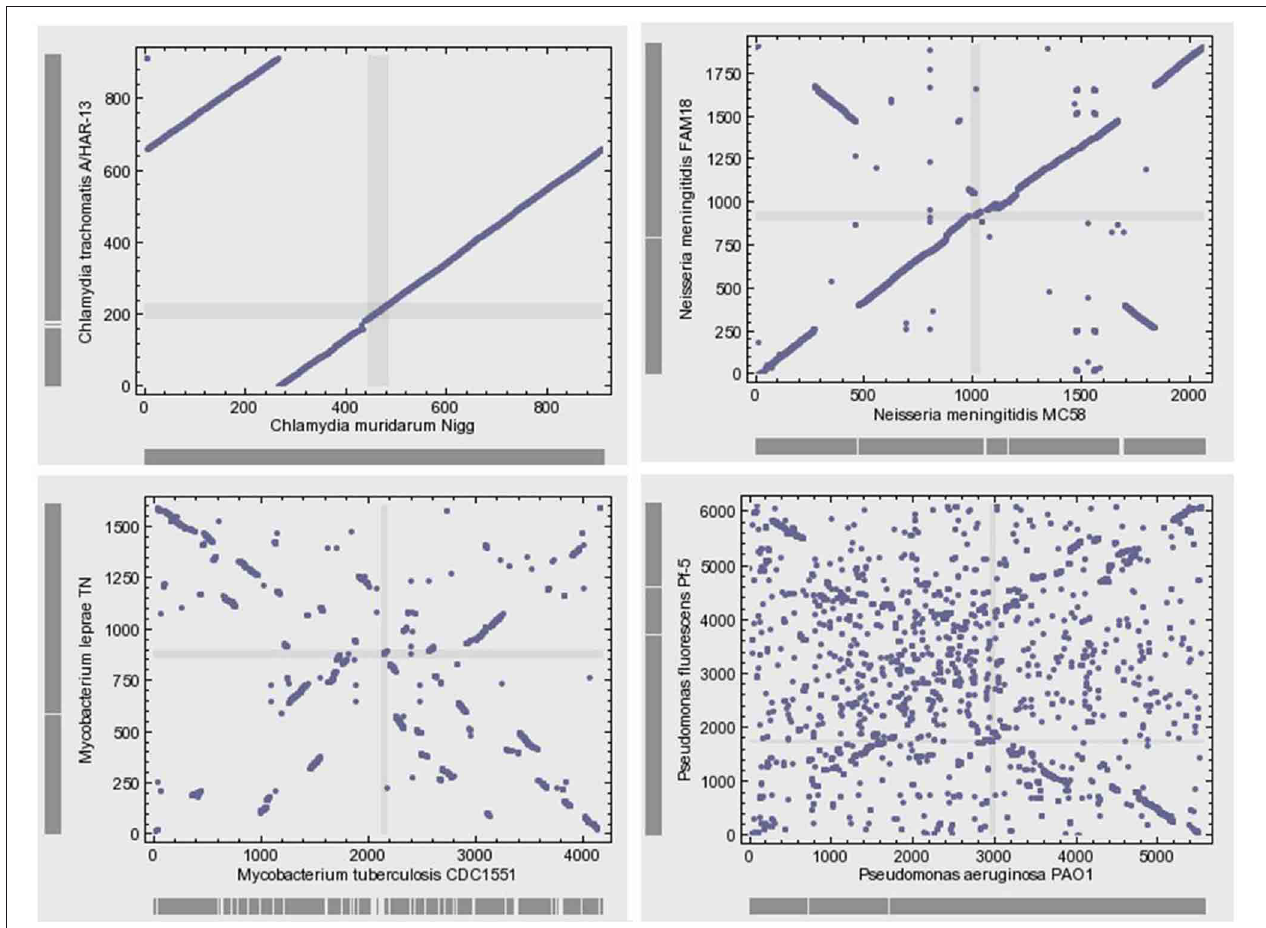
FIGURE 4 | Gene position plots of pairs of 4 selected genome pairs of bacteria show large variation between related species. This dynamic view of the genome rejects the evolution by